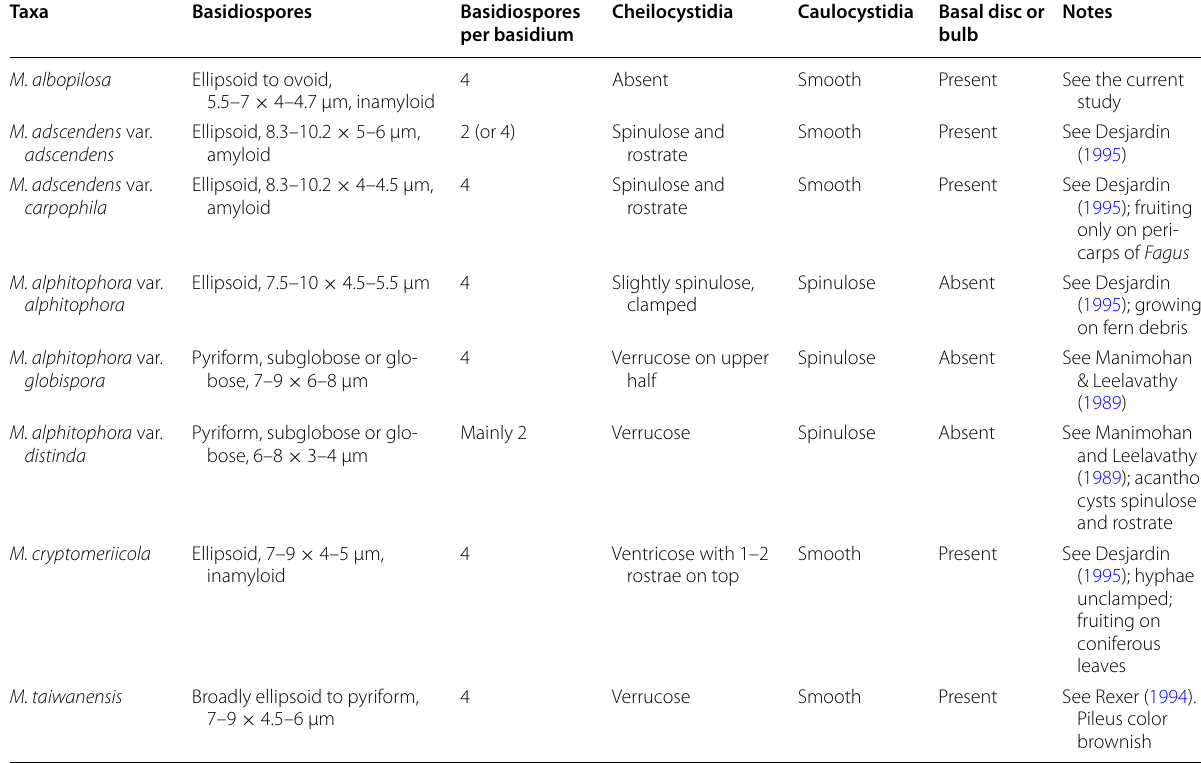
Table 1 Comparisons of M. albopilosa with similar